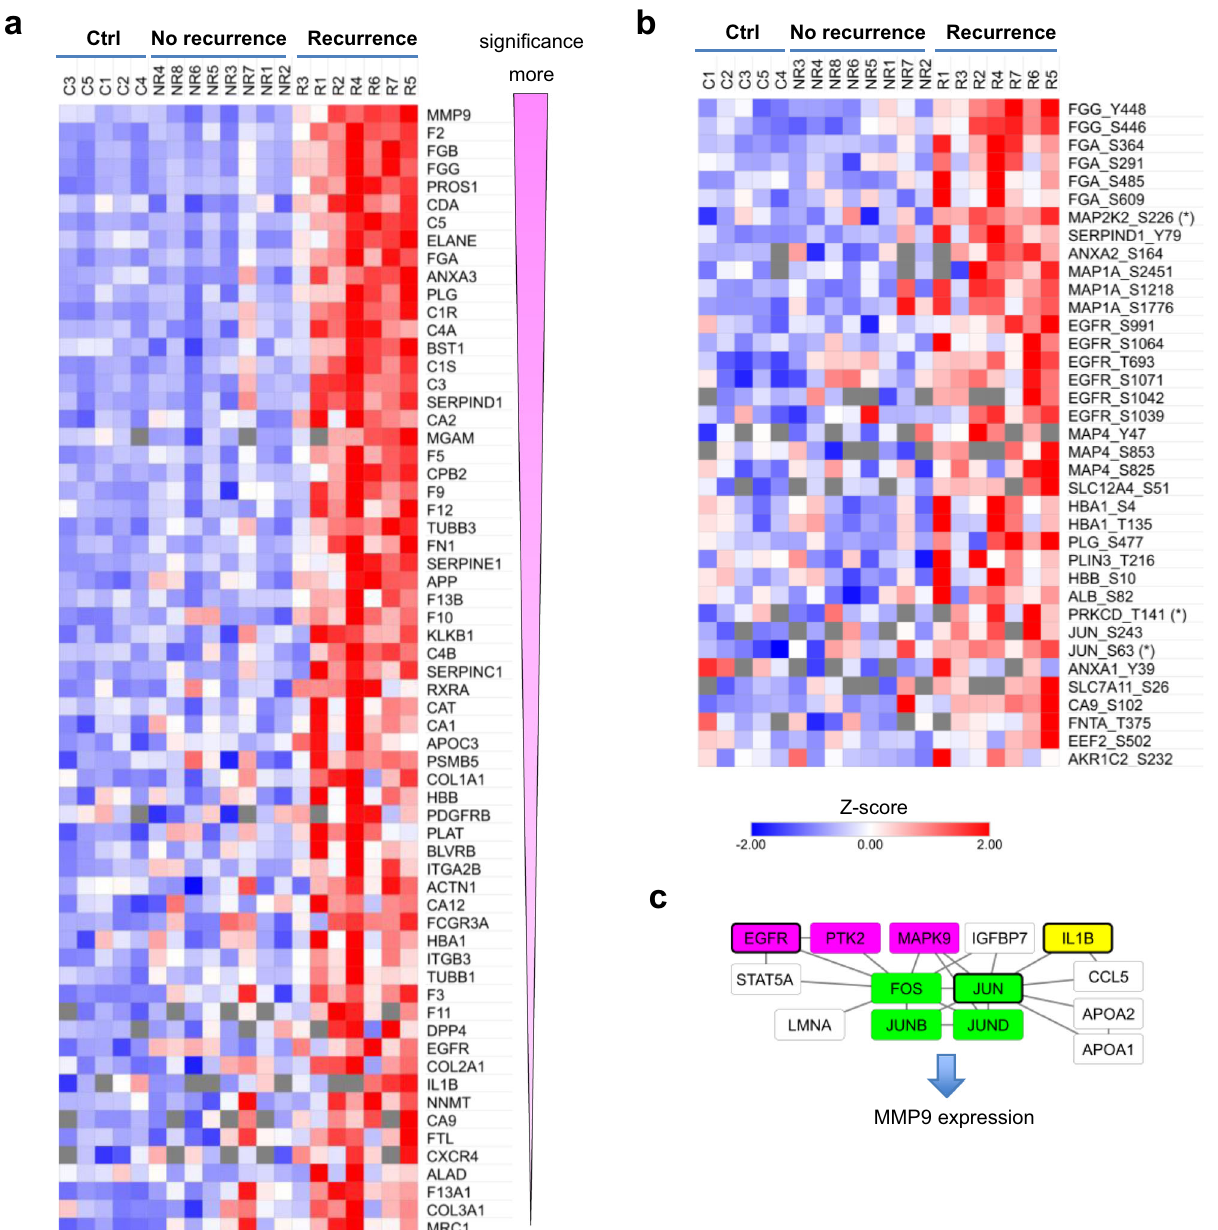
Fig. 6 Candidate therapeutic targets for precision treatment of recurrent HPV + HNSCC. a Heatmap showing overexpression of a list of FDA-approved therapeutic targets in the recurrent tumors. The proteins are sorted, from top to bottom, with the corresponding p values calculated from the proteome data between the NR and R group. Proteins with >1.5-fold increase in the R group and p < 0.1 between R and NR groups are included. EGFR and PDGFR are among the signi fi cantly upregulated therapeutic targets. b A list of FDA-approved drug targets with a signi fi cant increase in phosphorylation in the recurrent tumors. Asterisk(*): kinase activity-inducing residue (e.g., MAP2K2, PRKCD, c-Jun phosphosites) based on the PhosphositePlus database. Phosphosites with >1.5-fold increase in the R group and p < 0.1 between R and NR groups are included. c A kinase and cytokine signaling network that regulates increased MMP9 expression in the recurrent tumors. The nodes consist of proteins or phosphosites increased in the R group (>1.5-fold increase and p < 0.1 between the R and NR groups). Kinases are shown in magenta. Components of the AP-1 transcription factor complex, c-Jun/JunB/JunD/c-Fos, are in green. In all the panels, n = 8 for the NR group, and n = 7 for the R